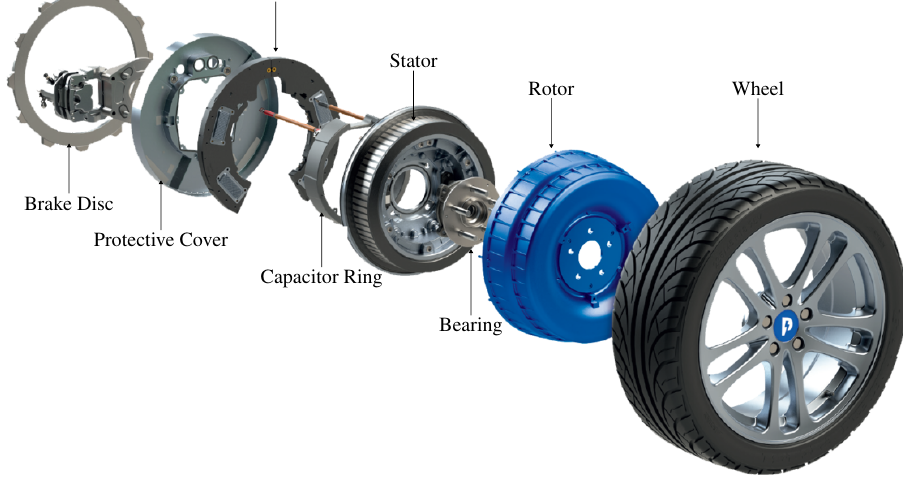
Figure 12. Protean Pd18 exploded view with integrated power electronics